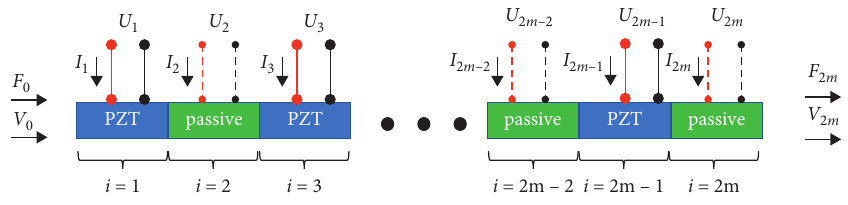
Figure 6: Electromechanical coupling model of